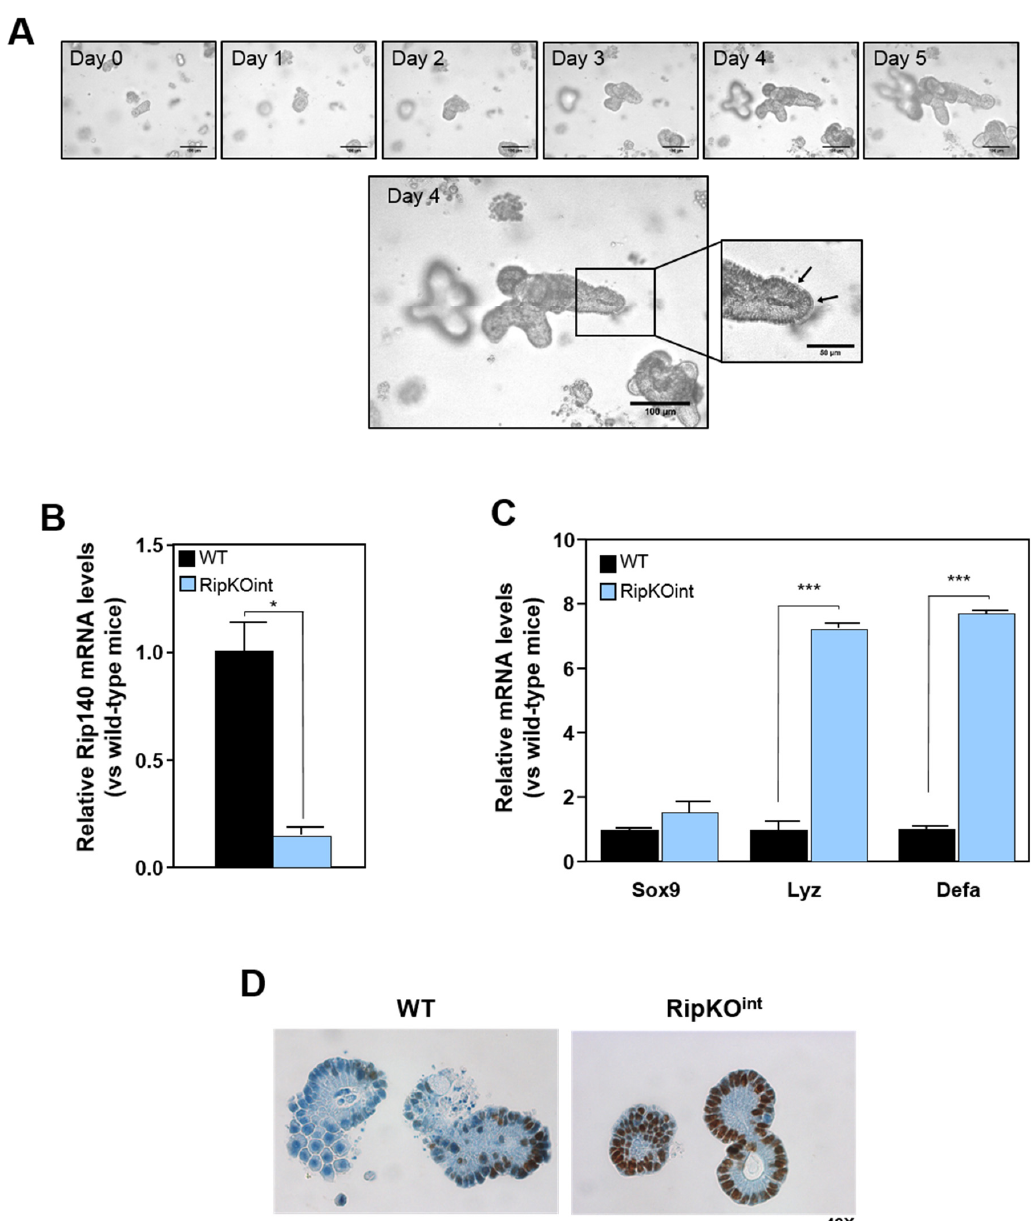
Figure 2. ( A ) Time course of an isolated single crypt growth. Differential phase contrast image reveals granule-containing Paneth cells at crypt bottoms (arrows). ( B ) RT-qPCR analysis of Rip140 and ( C ) Sox9, Lyz, and Defa in organoids derived from WT and RipKO int mice. The results are expressed in arbitrary units after normalization by RS9 mRNA levels. Values are the means ± SEM of 3 independent experiments. ( D ) Immunostaining of Sox9 in WT and RipKO int organoids. A Student t test was used for statistical analysis: * p < 0.05 and *** p < 0.001.